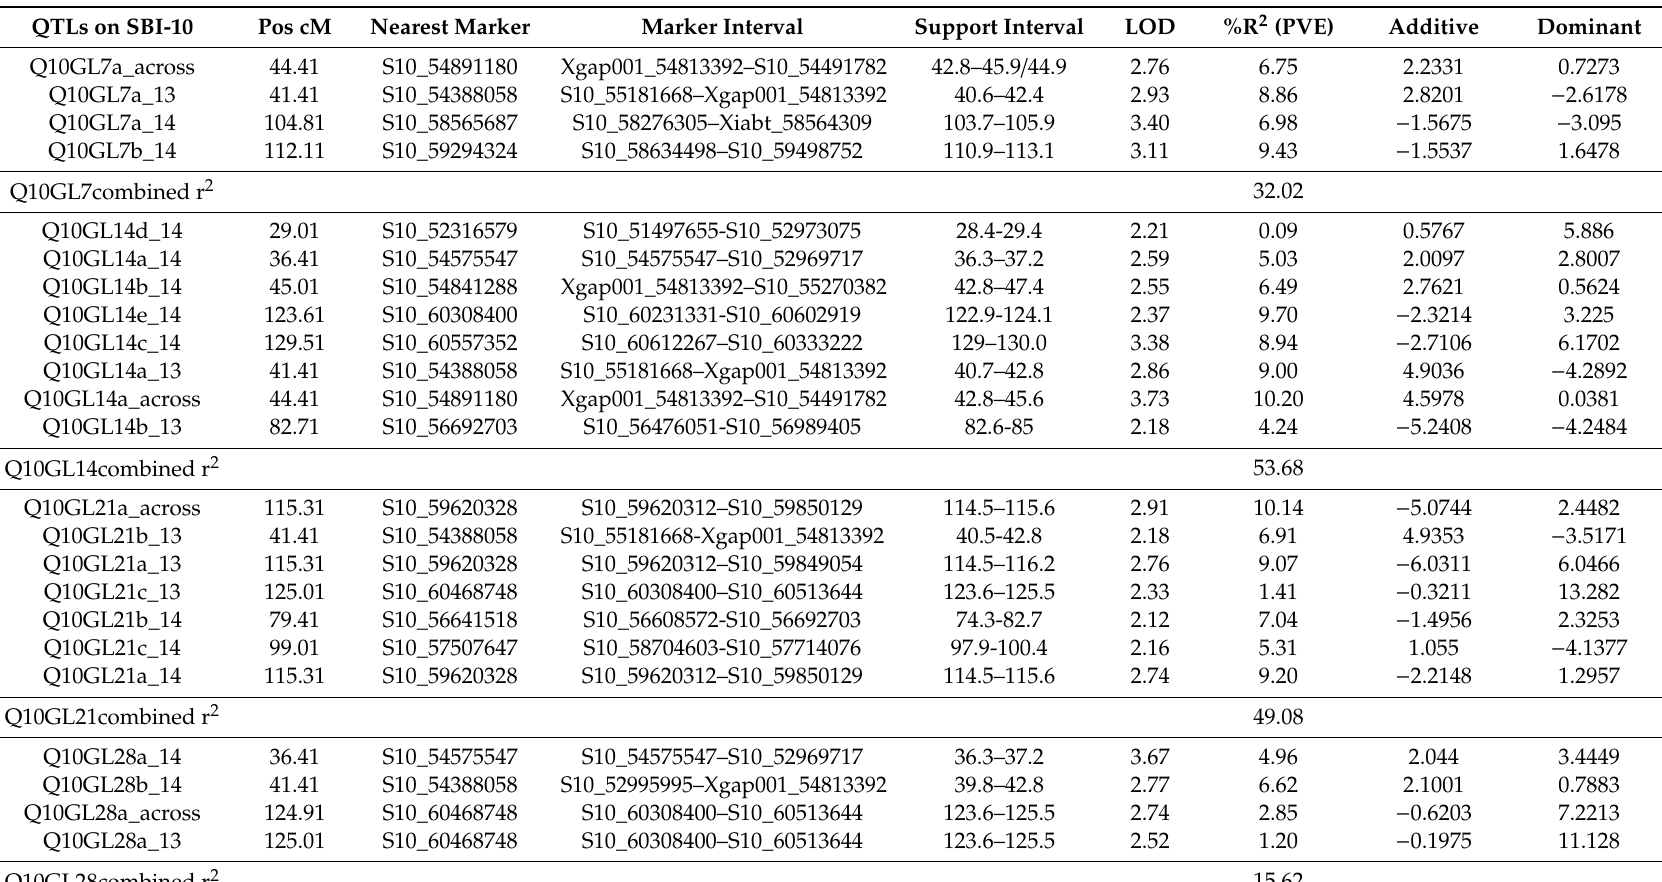
Table 4. Stay-green QTL mapping on SBI-10L for post-rainy 2013 (13), 2014 (14), and across the